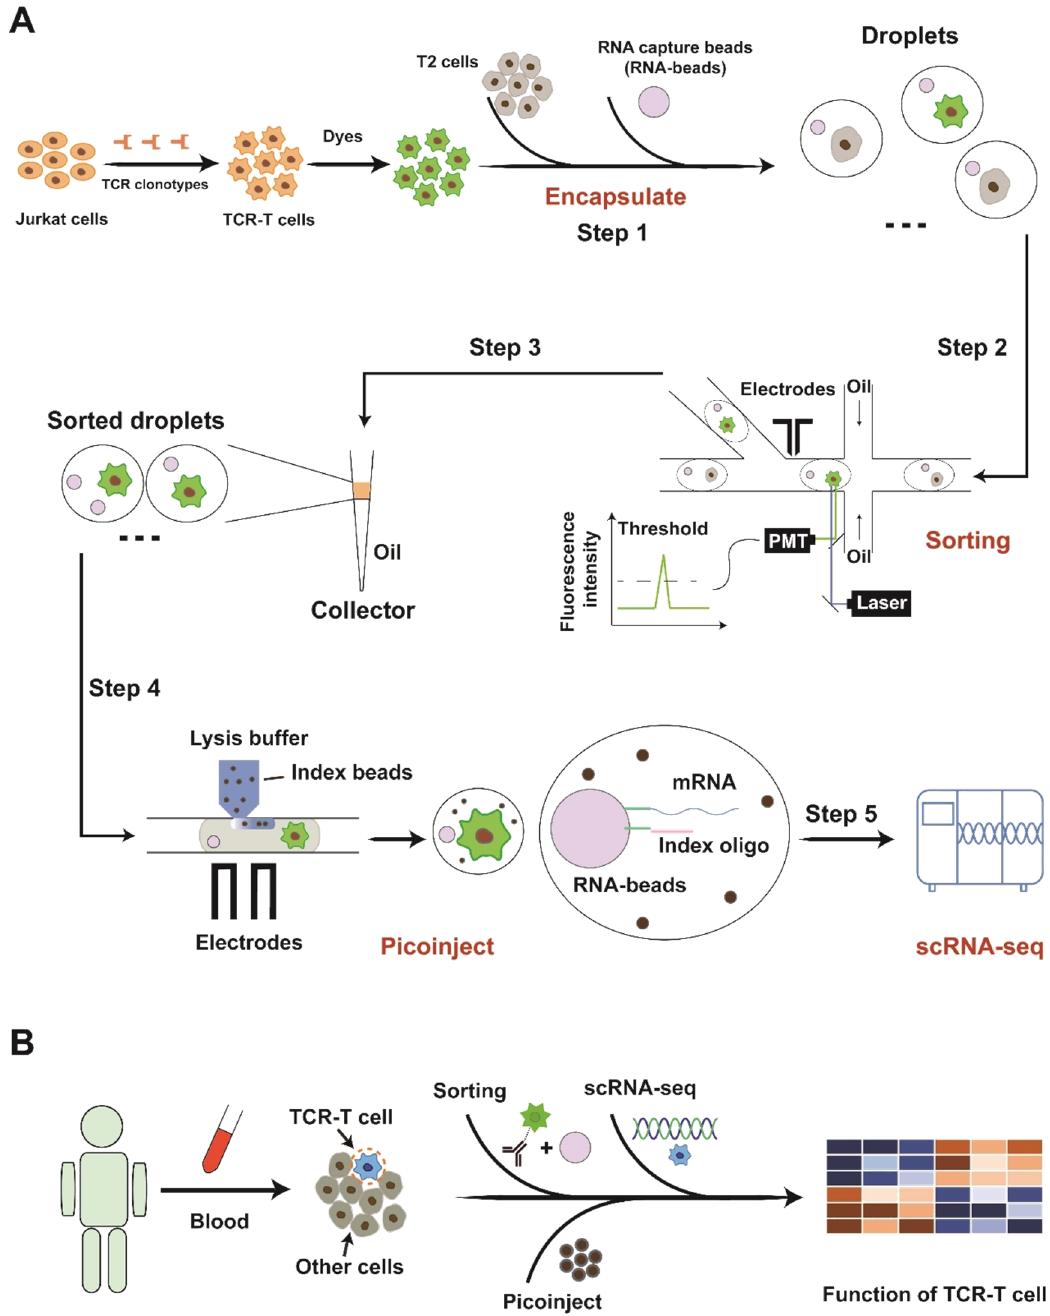
Figure 1. Schematic diagram of experimental flow. ( A ) Step 1: Droplet generation: Co-encapsulation of cells and RNA beads. Step 2: Droplet sorting: Fluorescence-activated droplet screening and sorting for enriching TCR-T cells. Step 3: Droplet collection; Step 4: Droplet picoinject: Inject reagent (lysis buffer and index beads) into sorted droplet for scRNA-seq. Step 5: Single-cell RNA-sequencing: Capture transcripts, prepare library and perform scRNA-seq. ( B ) The strategy for monitoring infused TCR ‐ T cells in clinic application.